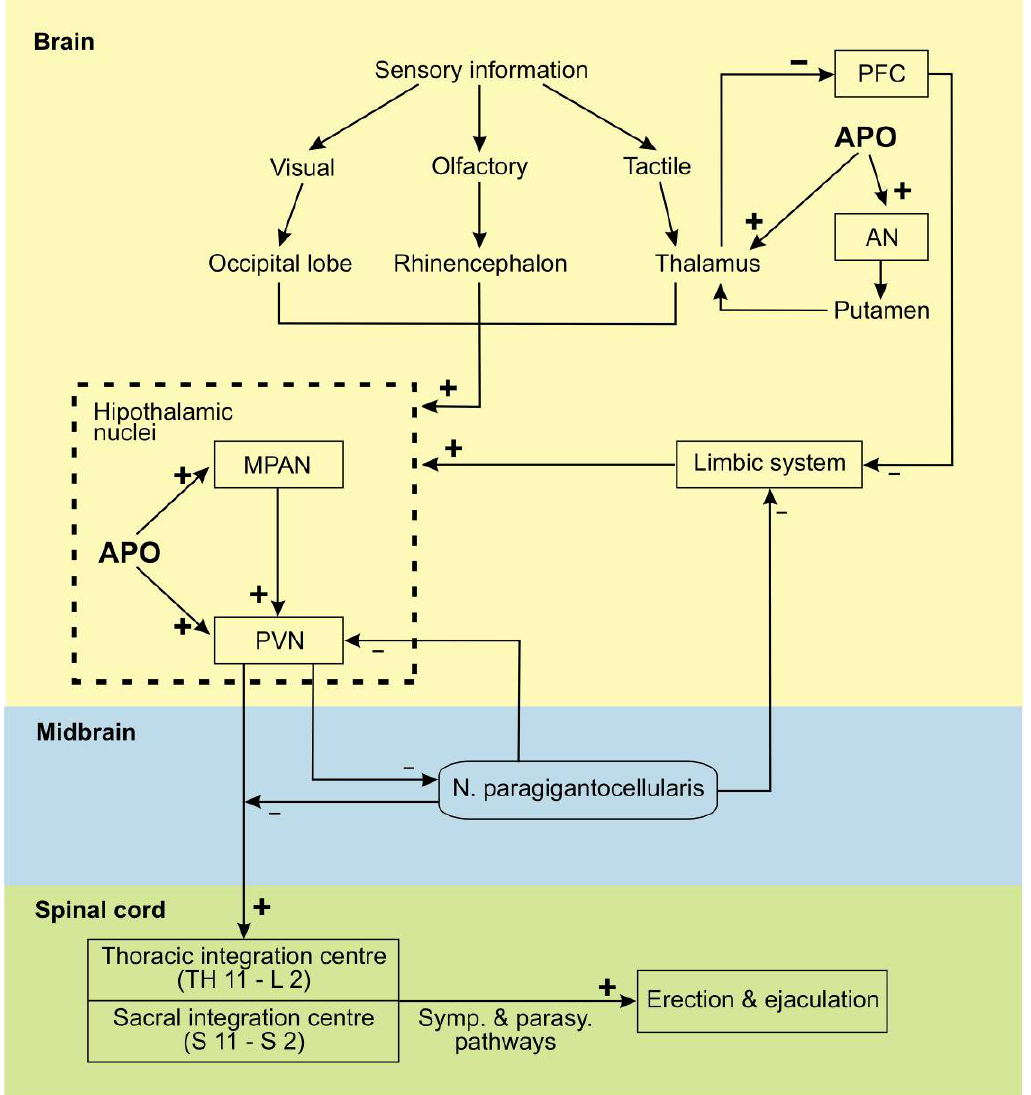
Figure 2. Central pathways controlling erection and ejaculation [36,42,43]. AN (accumbens nucleus); APO (apomorphine); MPAN (medial preoptic area nucleus); PFC (prefrontal cortex); PVN (paraventricular nucleus);  (accentuated activity); − (attenuated activity). Central dopaminergic neurons form synapses in the PVN and MPAN and dopaminergic neurons project from the hypothalamus to the spinal cord. APO promotes erection by acting mainly on the D -like receptors in the central nervous system. The effect 2 of APO on erection and ejaculation is shown with bold ( + ) or ( − )